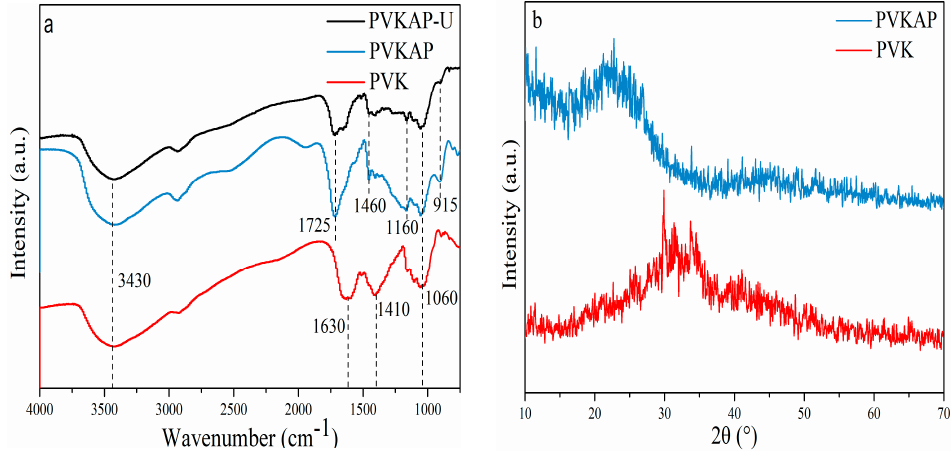
Figure 2. ( a ) FTIR spectra of PVK and PVKAP; ( b ) XRD patterns of PVK and PVKAP.